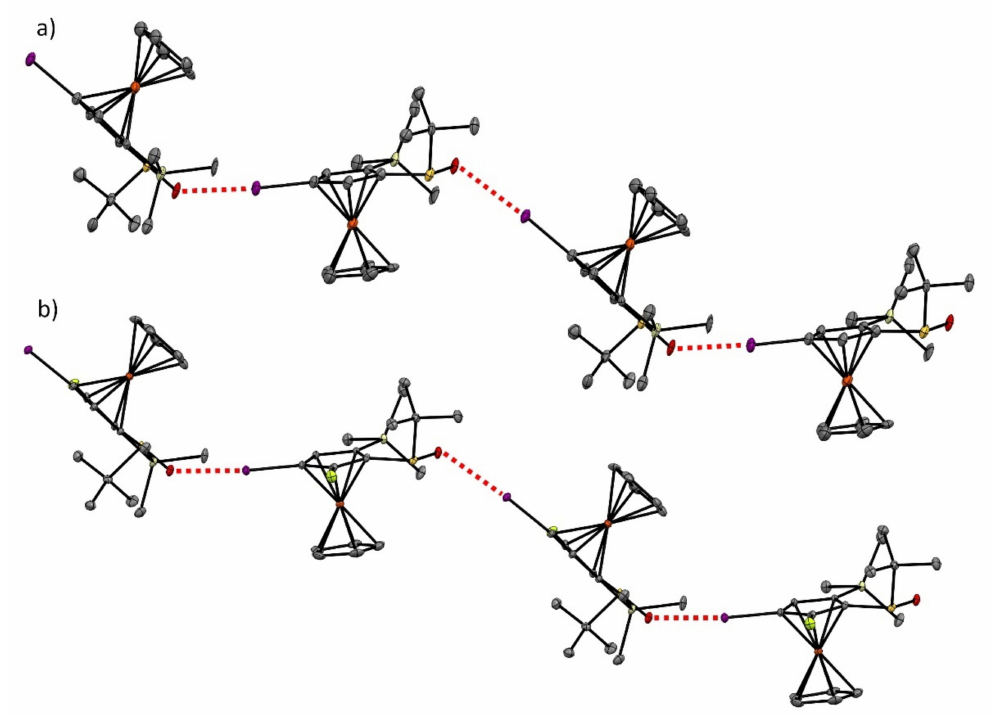
Figure 6. Halogen bond network observed at the solid state for the compound ( a ) S , S P -7 and ( b ) S , S P - 9b . Thermal ellipsoids shown at the 30% probability level. The hydrogens were omitted for